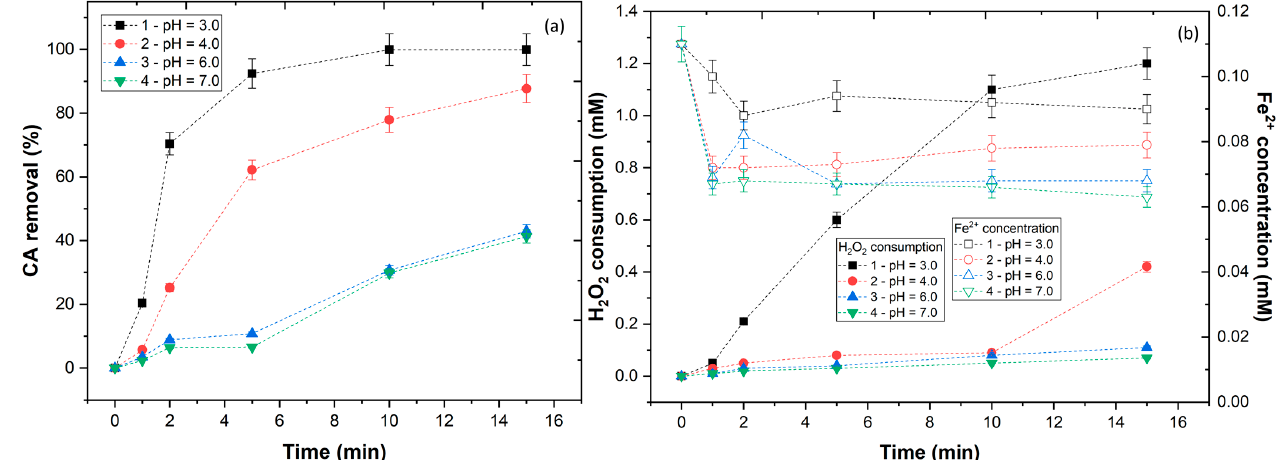
Figure 3. Effect of pH in ( a ) CA removal and ( b ) H 2 O 2 consumption and Fe 2+ concentration. Operational conditions: [CA] = 5.5 × 10 − 4 mol L − 1 , [H 2 O 2 ] = 2.2 × 10 − 3 mol L − 1 , [Fe 2+ ] = 1.1 × 10 − 4 mol L − 1 , agitation 150 rpm, temperature = 298 K, radiation UV-A, I UV = 32.7 W m − 2 , t = 15 min.